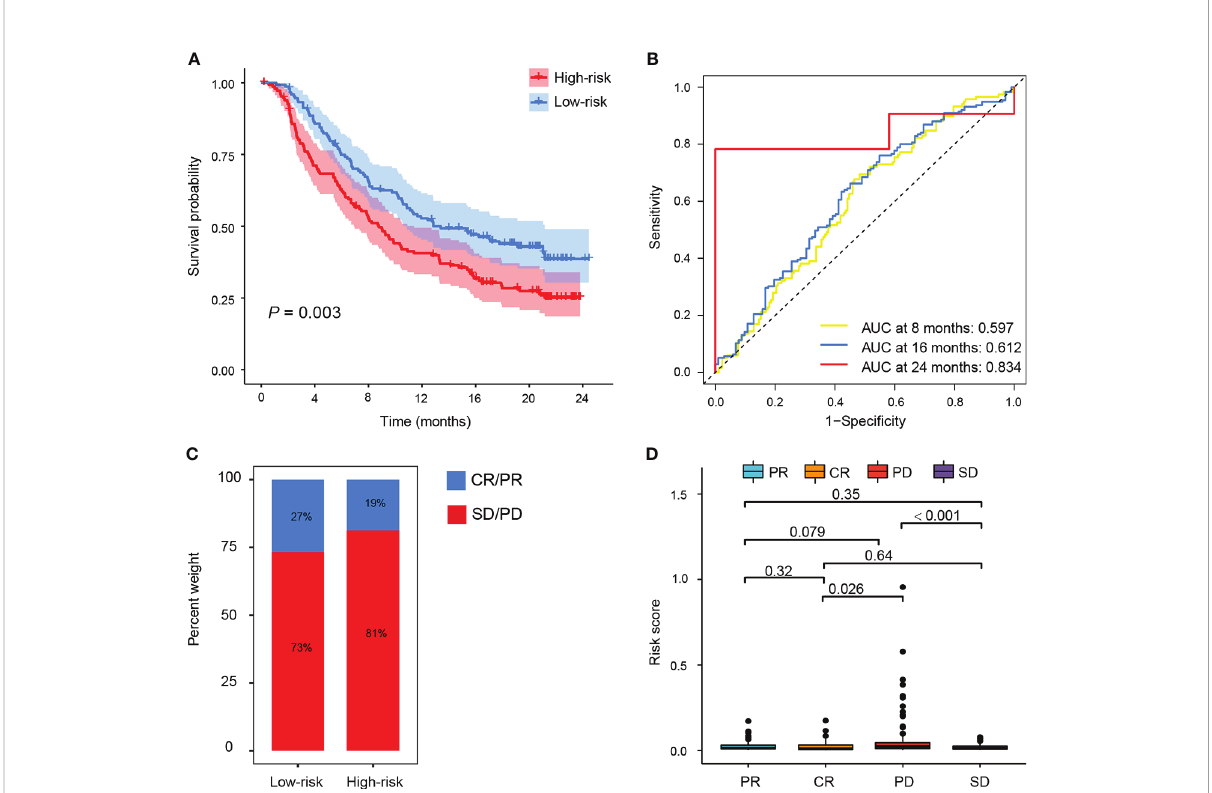
FIGURE 6 The prognostic value of PTS in patients with anti-PD-L1 therapy. (A) Kaplan – Meier curves of OS between the high-risk and low-risk groups in the IMvigor210 cohort. (B) ROC curves showed the performance of the risk score in predicting the 8-, 16-, and 24-month OS in the IMvigor210 cohort. (C, D) Risk score in patients with different responses to PD-1 treatment [complete response (CR), progressive disease (PD), partial response (PR), and stable disease